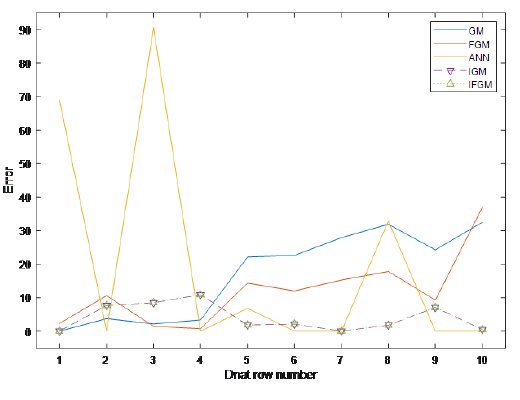
Figure 6: Modeling